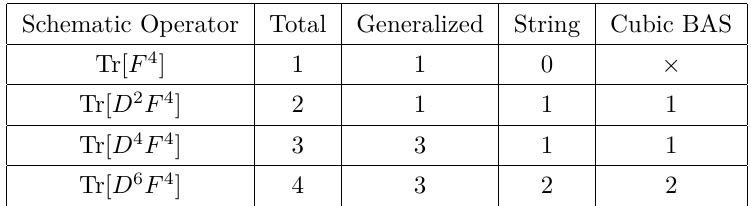
Table 2 . Number of tunable parameters in the operator coefficients contributing to the